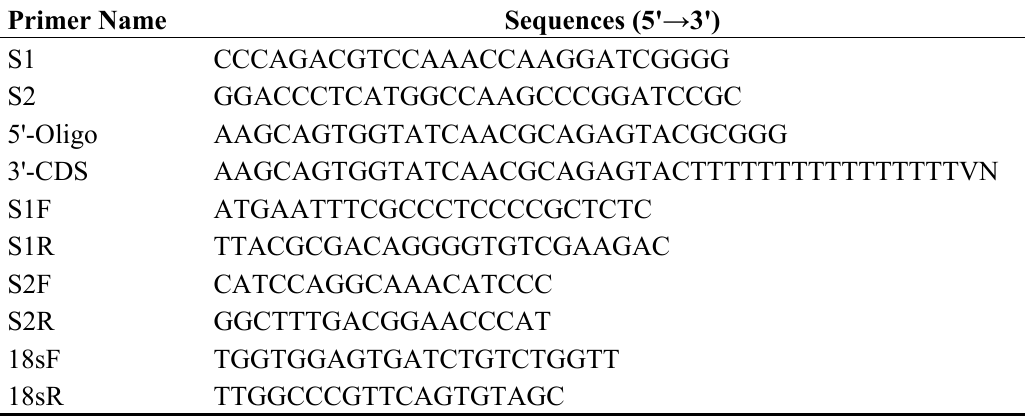
Table 1. Nucleotide sequences of primer pairs used for PCR ampli fi cation.